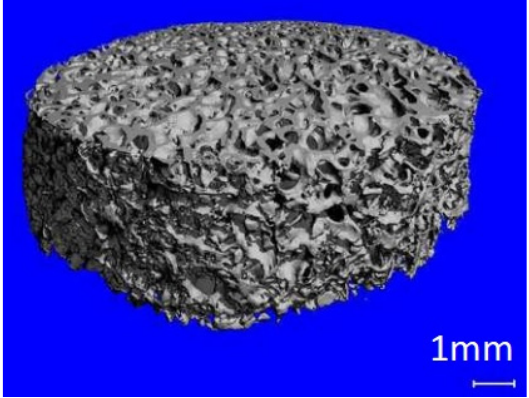
Figure 3. Decellularized cancellous bone scaffold.